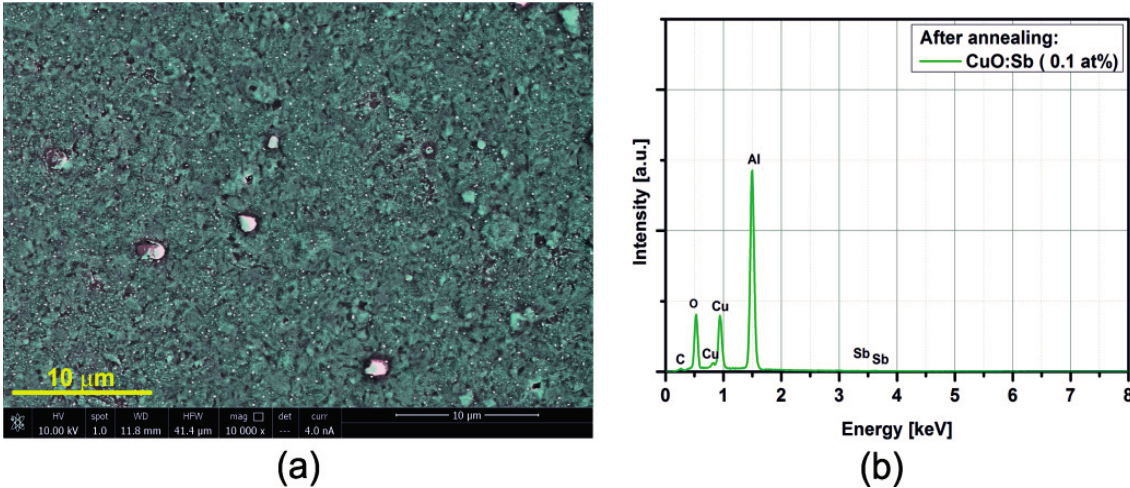
Figure 10. ( a ) SEM image; ( b ) EDX distribution of the Sb:CuO-based sensor (Sb: